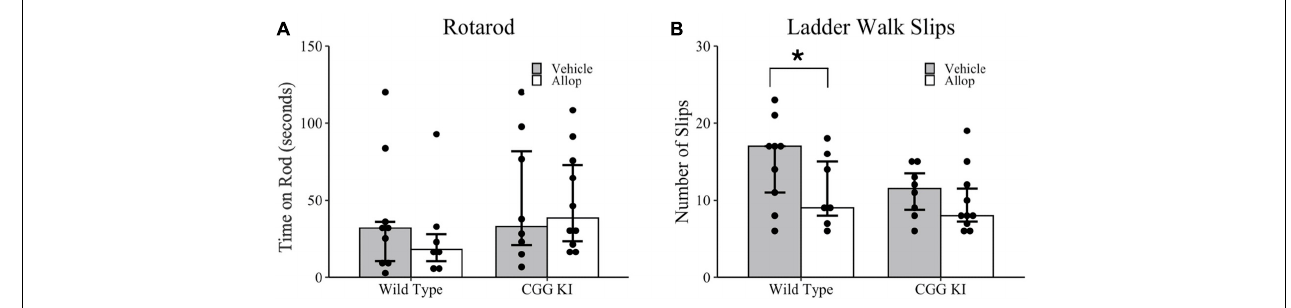
FIGURE 3 | Behavioral assessments of balance and motor coordination in response to Allop in the wild type and CGG KI mouse. Following 10 weeks of Allop treatment mice were evaluated for changes in balance on the rotarod task and motor coordination in the ladder rung task. (A) No differences were observed in the average time to fall in the rotarod task. (B) In the ladder rung task, mice were evaluated for total number of slips. * p < 0.05 as deteremined by Wilcoxon-Mann-Whitney (Rotarod) or Poisson Regression (Ladder Walk) followed by pairwise planned comparisons. Plots represent individual mice; bars represent